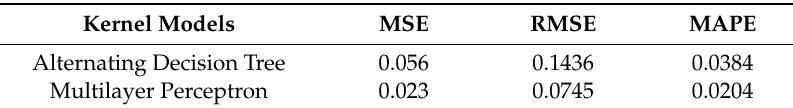
Table 3. The error rates.